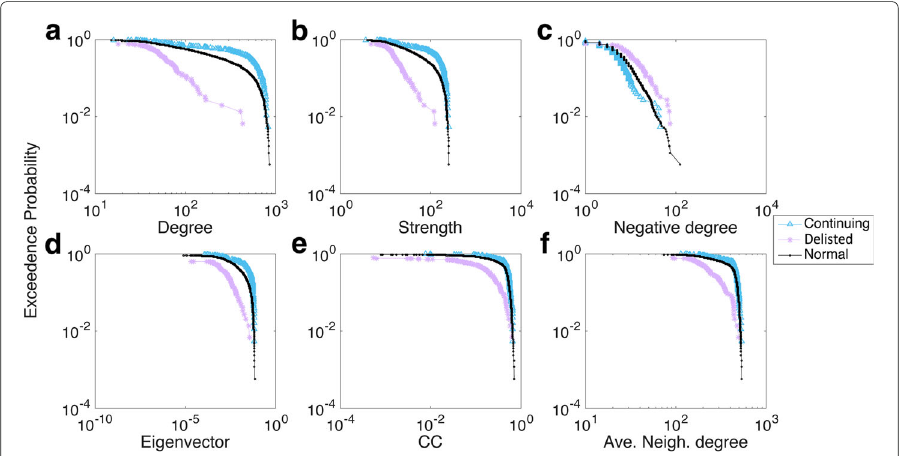
Fig. 3 Distribution of the six network measures in 1988-1989. a Degree; b Strength; c Negative degree; d Eigenvector; e CC; f Ave. Neigh.